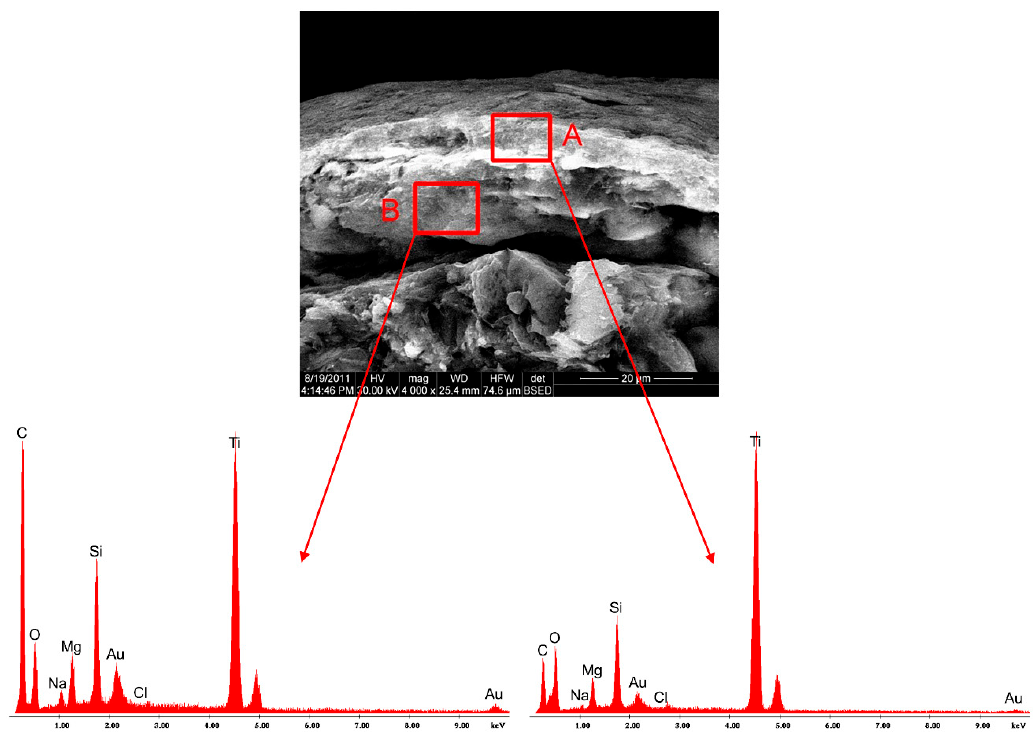
Figure 7. ( a ) SEM image (1000 × ) of the cross-section of MXA samples; ( b ) example of SEM image (4000 × , BSED) of the cross-section of MXA samples.